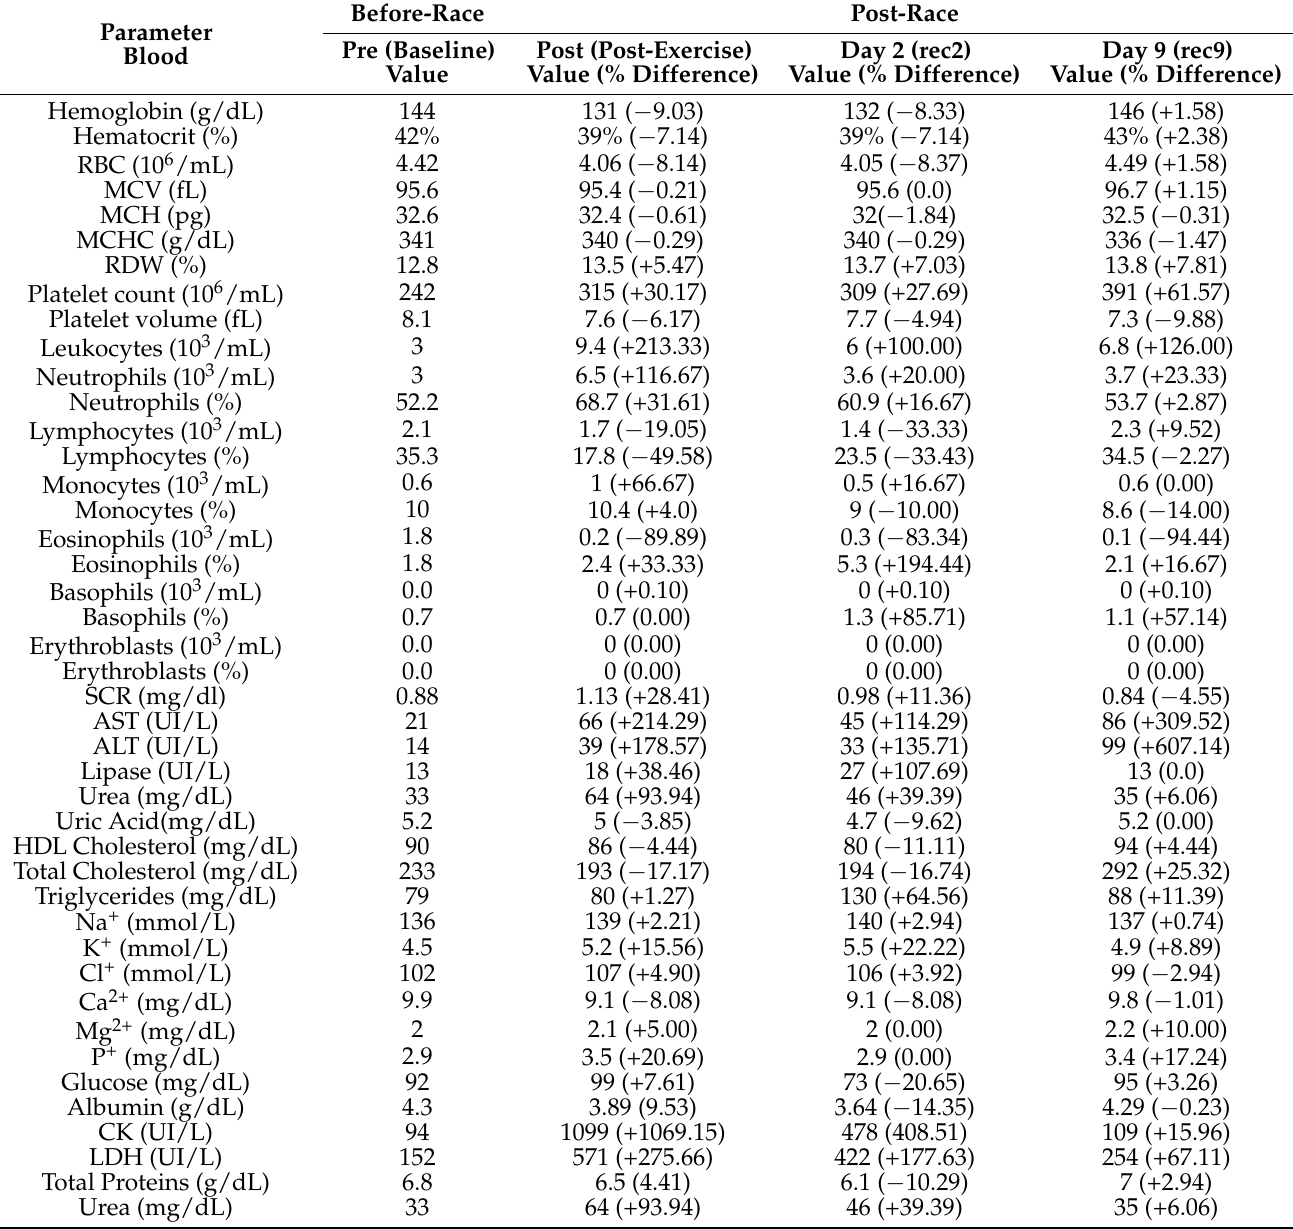
Table 1. Blood and urine parameters before (baseline) and after race (post-exercise day 2 and post-exercise day 9). Before-Race Post-Race Parameter Pre (Baseline) Post (Post-Exercise) Day 2 (rec2) Day 9 (rec9) Blood Value Value (% Difference) Value (% Difference) Value (% Difference) Hemoglobin (g/dL) 144